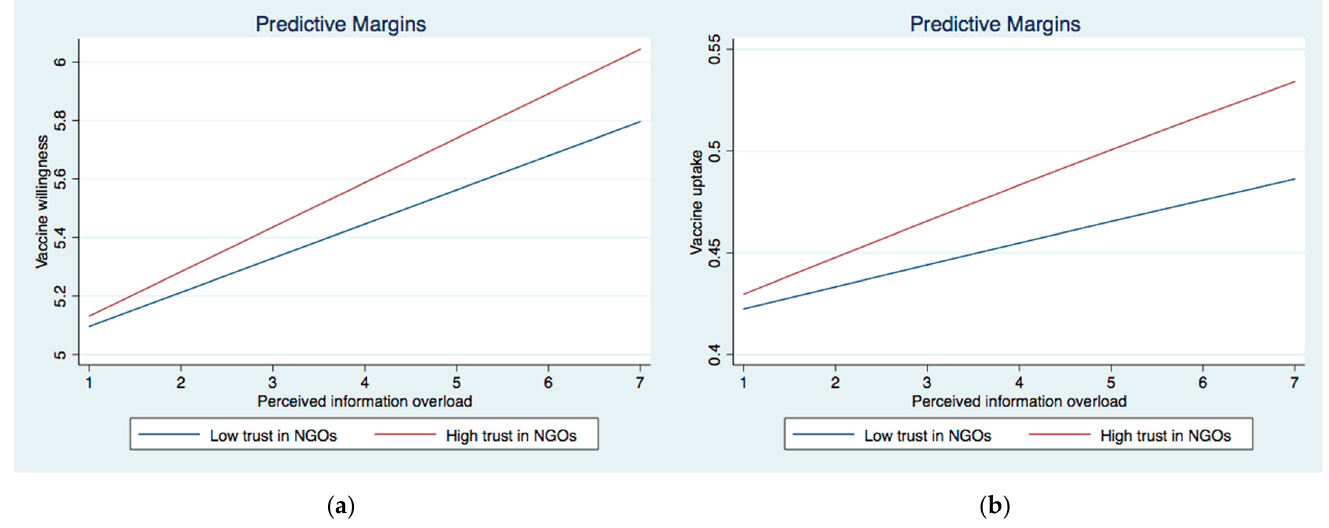
Figure 2. ( a ) Interaction between perceived information overload and trust in NGOs on vac- cinewillingness. ( b ) Interaction between perceived information overload and trust in NGOs trust on vaccine uptake.